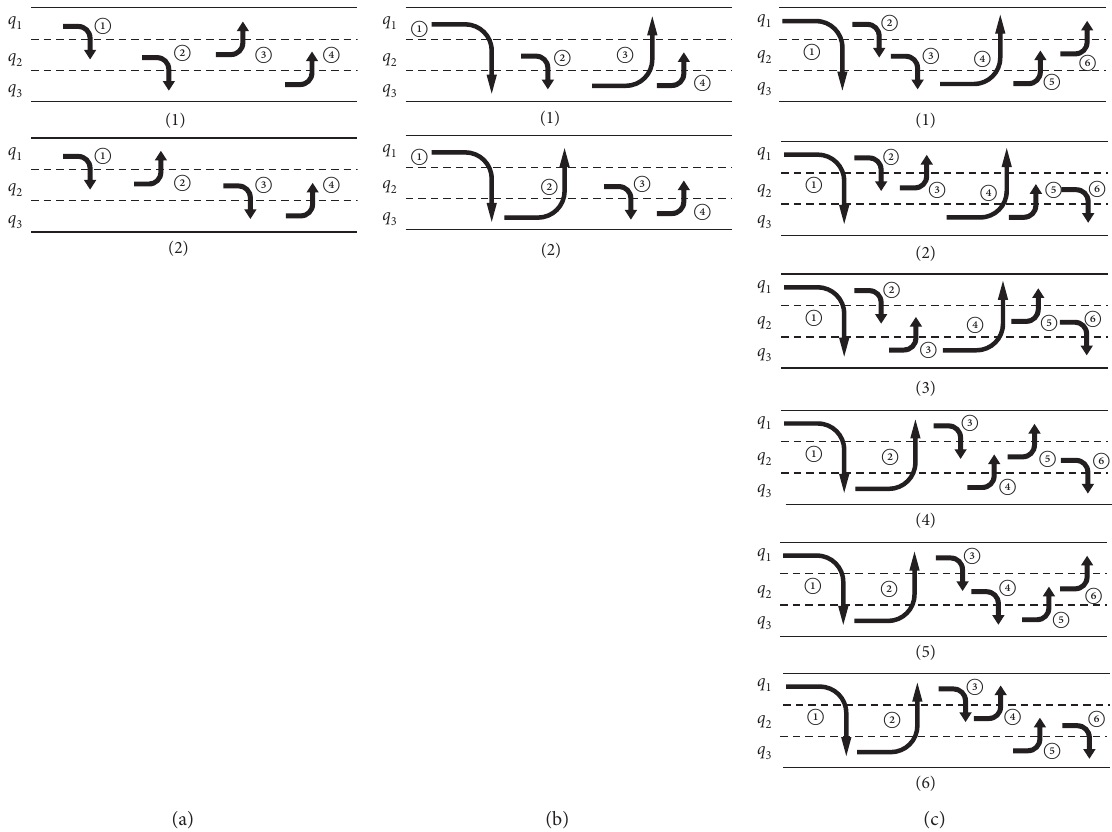
Figure 3: Path selections of lane-changing behaviors: (a) p � 0; (b) p � 1; and (c) 0 < p < 1.